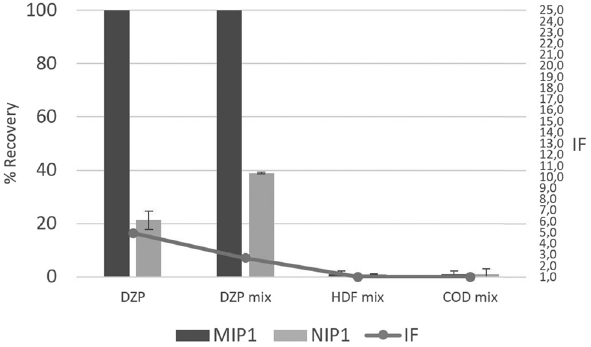
Figure 6: Recoveries of DZP spiked blood serum with and without another compound. DZP: serum spiked with DZP alone without other compounds. DZP mix: serum spiked with DZP, HDF, and COD and measured the DZP recoveries. HDF mix: serum spiked with DZP, HDF, and COD and measured the HDF recoveries. COD mix: serum spiked with DZP, HDF, and COD and measured the COD